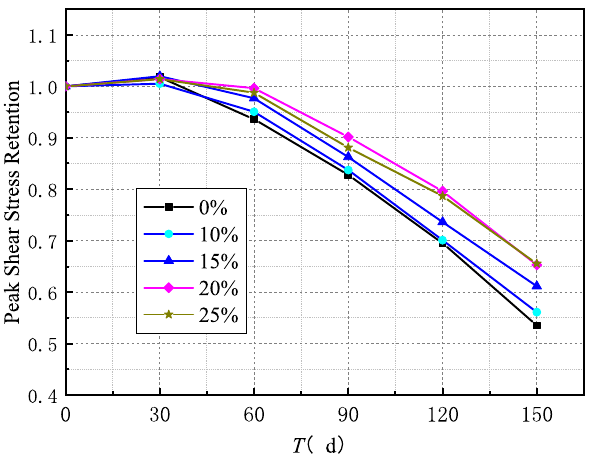
Figure 9. Time-varying curve of peak shear stress.